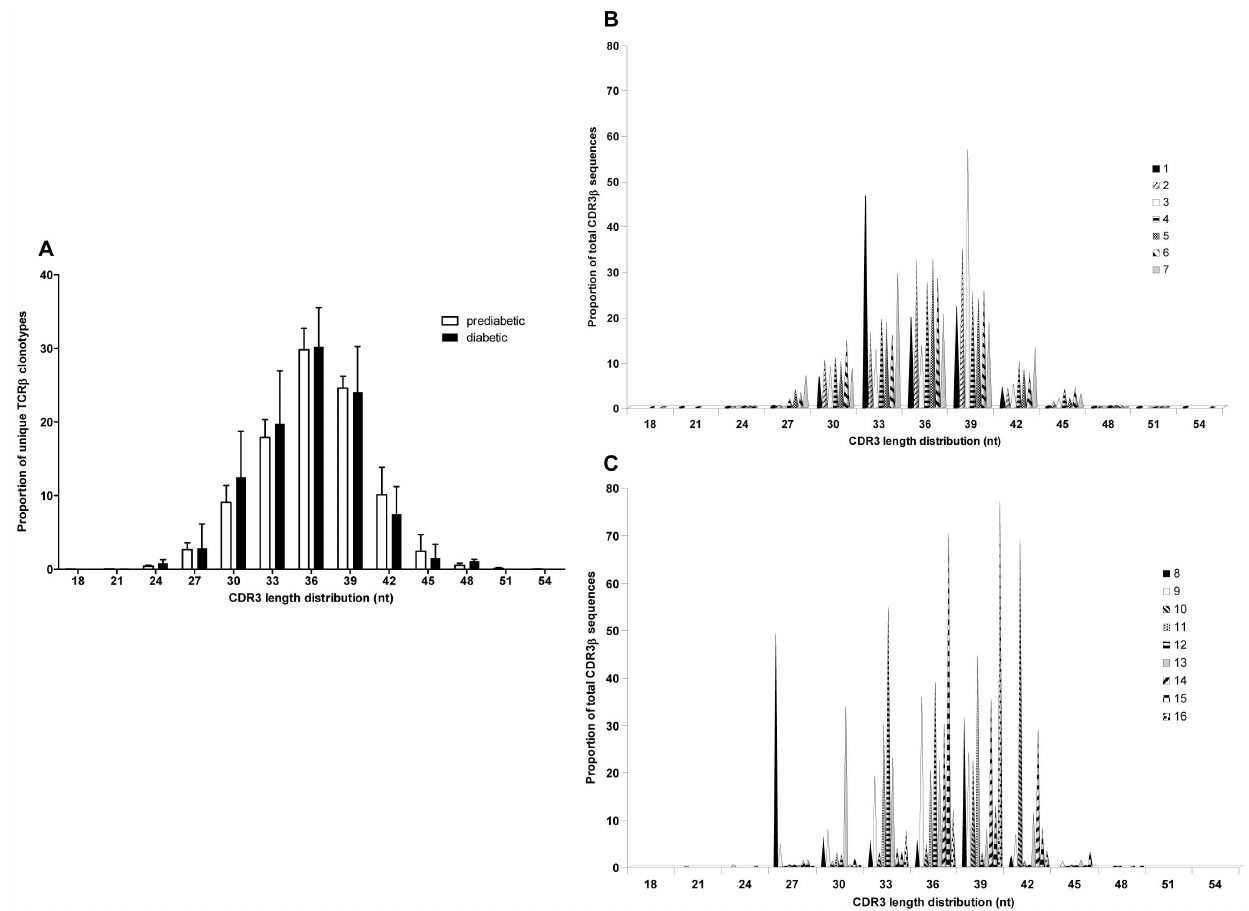
Figure 5. CD4 + CD44 high clonotypes from prediabetic and diabetic mice have similar CDR3 b length distribution. (A) The distribution of CDR3 lengths for all unique CD4 + CD44 high clonotypes are presented as means 6 SEM of prediabetic (white bar) and diabetic (black bar) mice. The distribution of CDR3 b lengths are shown for individual prediabetic mice (B) or diabetic mice (C).